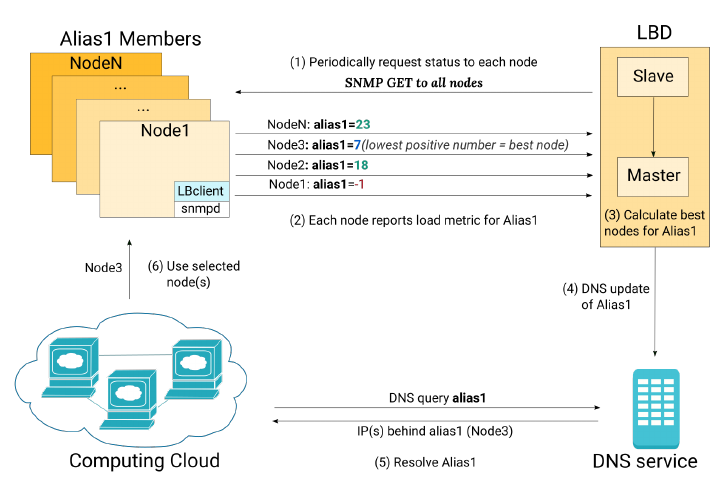
Figure 1: Components of the Load Balancing